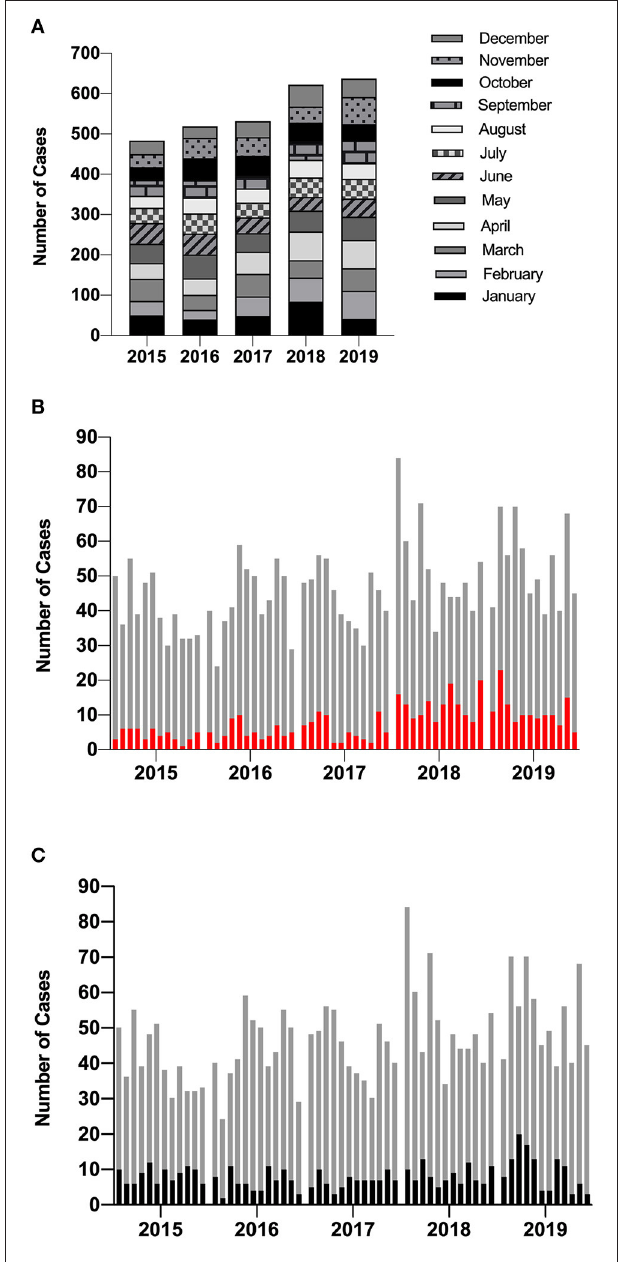
FIGURE 1 | Incidence of new HAdV cases diagnosed using PCR by the diagnostic laboratory. (A) The total number of HAdV cases identified by GOSH increased each year but did not demonstrate any seasonality. (B) The proportion of new positives that were documented as HCAI are shown in red and (C) the proportion of new positives identified from patients admitted to the high-risk HSCT unit are highlighted in black. Each column represents a calendar month. HAdV, human mastadenovirus; PCR, polymerase chain reaction; GOSH, Great Ormond Street Hospital; HCAI, healthcare-acquired